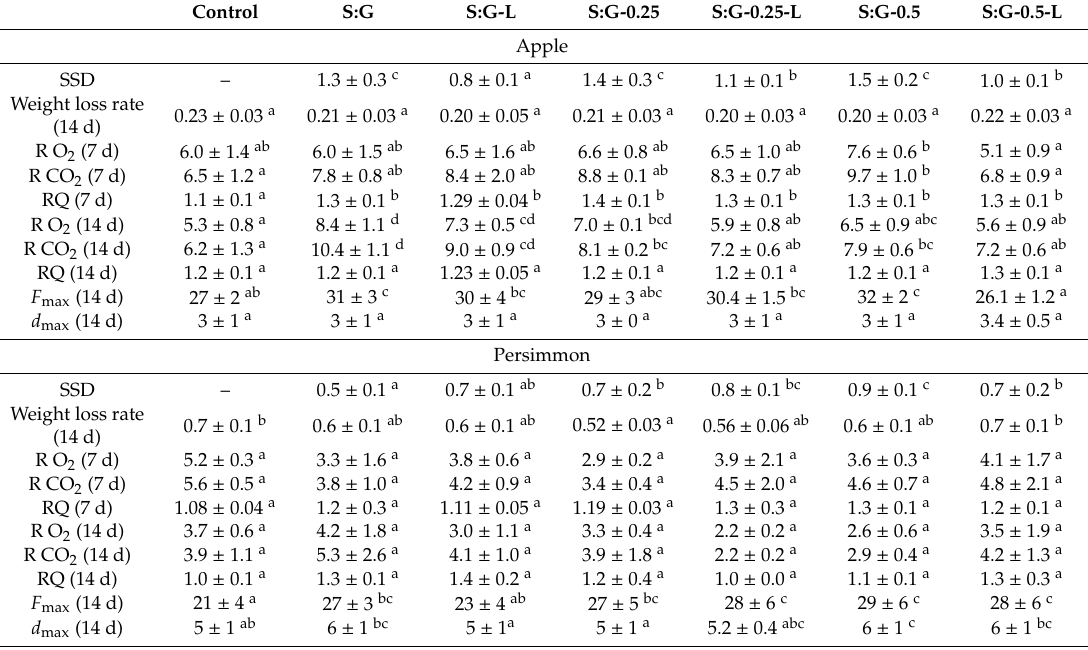
Table 4. Surface density of solids (SDS, g · m − 2 ), weight loss rate (day − 1 ), respiration rates (consumption of O 2 and production of CO 2 , mL · kg − 1 · h − 1 ), respiration quotient (RQ), maximum puncture force ( F max , N), and penetration distance ( d max , mm) of coated and uncoated ‘Golden Delicious’ apples and ‘Rojo Brillante’ persimmons for 7 or 14 days of storage at 25 ◦